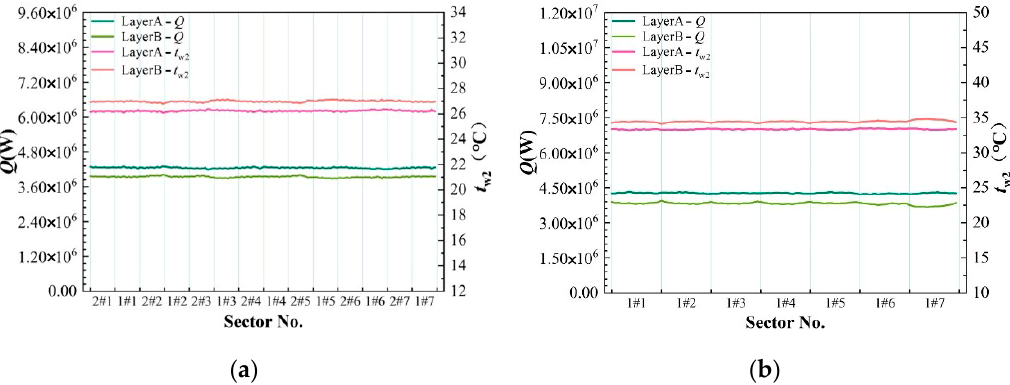
Figure 6. Heat rejections and water outlet temperatures of double-layer cooling deltas in the absence of wind. ( a ) In the case of 2 units; ( b ) in the case of 1 unit.